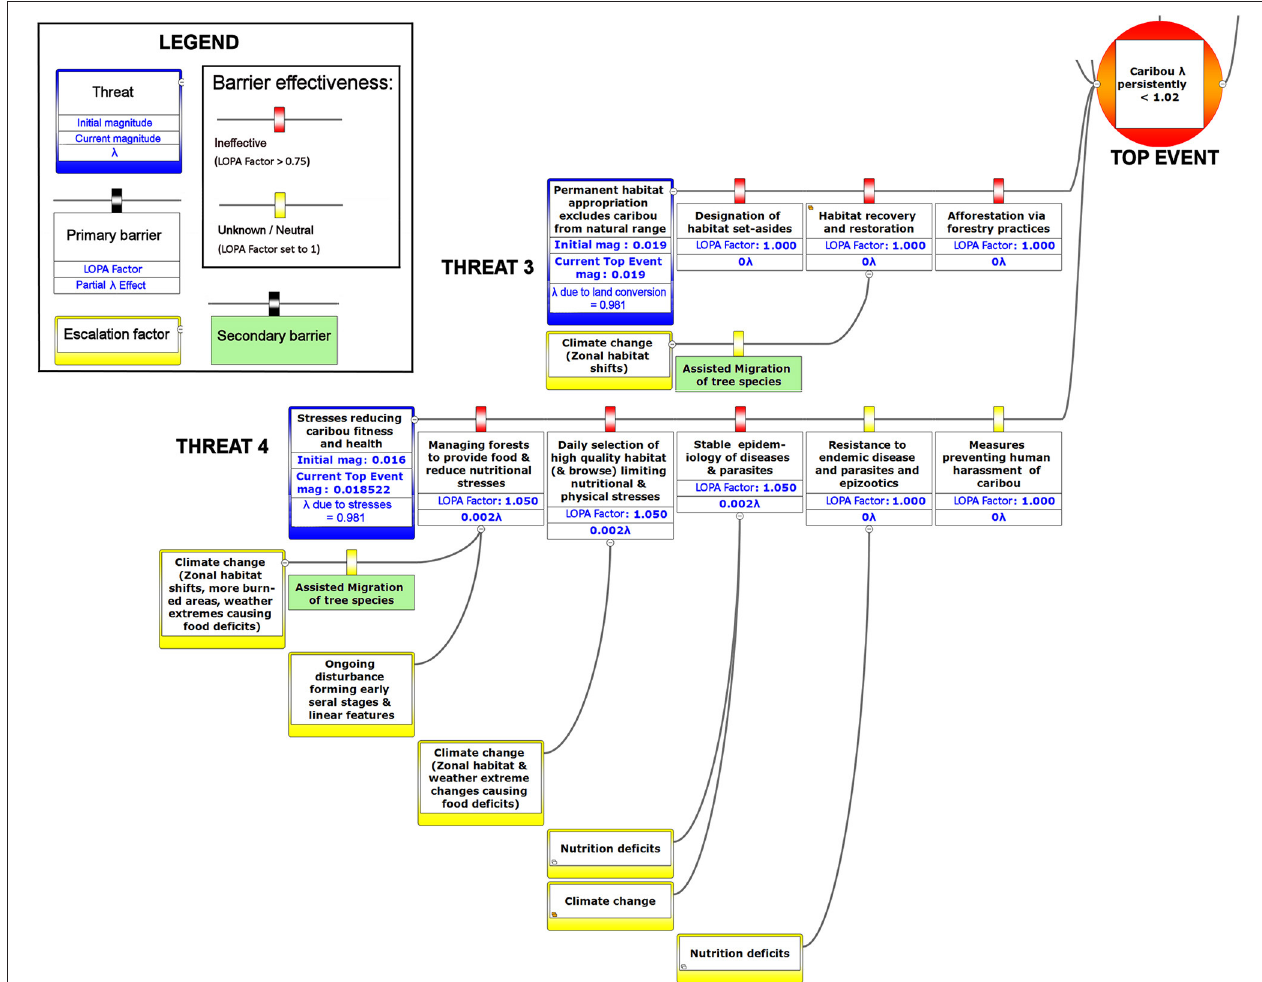
FIGURE 7 | The lower left-hand portion of a bow-tie diagram that visualizes cumulative environmental threats to the boreal caribou meta-population. The top event (red circle, right) is a circumstance where the population growth rate of caribou ( λ ) persistently falls below 1.025. Natural and anthropogenic factors potentially causing the top event are shown in blue boxes on the left panel. Unchecked, the cumulative threats shown in this figure lead to caribou λ persistently < 1.025; the colored boxes placed between threats and the top event show natural factors and human interventions that are potential barriers to the threats. For each threat, relevant factors that increase risks by limiting barrier effects (escalation factors) are shown in yellow boxes linked to the relevant barriers. Secondary barriers that may reduce or nullify the escalation of risk are shown along the lines leading from escalation factors to the primary threat barriers. The numbers appearing in the blue threat boxes correspond to mean current LOPA incidence for the Chinchaga herd (1.0 = 100% probability of occurrence). Numbers in the barrier boxes correspond to the mean current probability-based LOPA factor for barrier or mitigation failure (1.0 = 100%; greater values compensate for natural vs. altered conditions and unfactored threat incidence). The top event box contains target values for sustainable thresholds. To assist with visual interpretation of the LOPA figures, the barriers are color-coded according to the LOPA factor (green < 0.75, yellow = 1.0 indicating uncertain